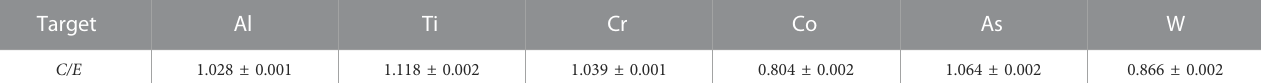
TABLE3 C / E withonestandarddeviationfortheaccumulatedneutronyieldsintheneutronenergyregionfrom0.1MeVto15 MeVfromAl,Ti,Cr,Co,As,andWpilesfor a 250-keV D-T neutron source. The experimental data only includes uncertainty due to counting statistics.